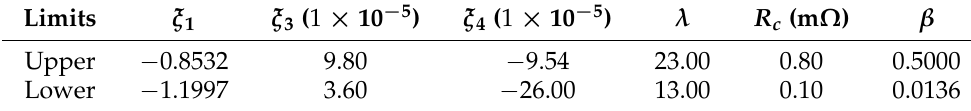
Table 1. Upper and lower limitsfor unknown parameters of a PEFC mathematical